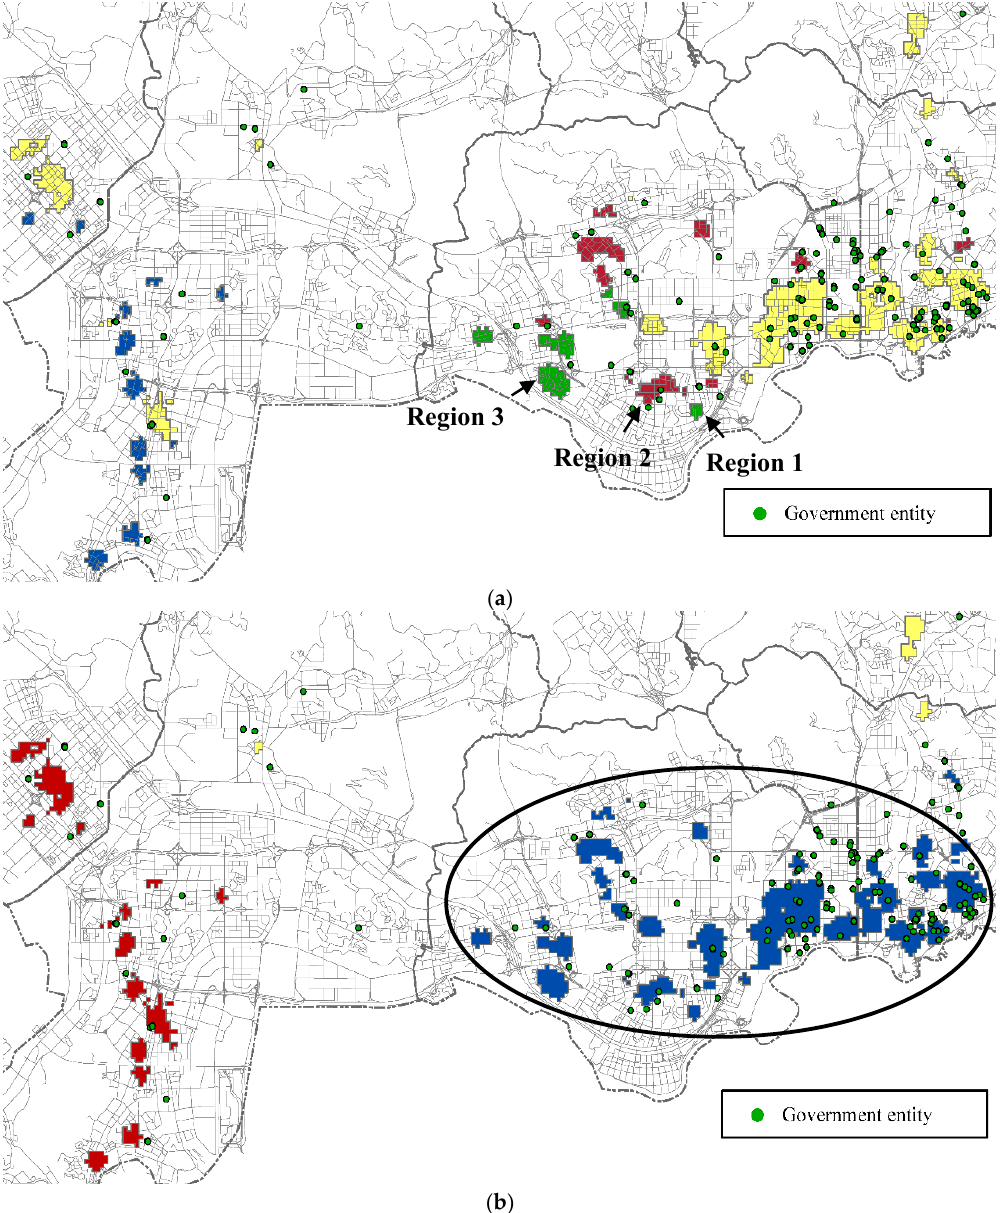
Figure 10. A more detailed comparison of clustering result: based solely on location-based variable ( b ); and based on both location-based variable and environmental variables ( a ) (i.e., the street network accessibility and the government entity density), for the size-2 pattern {bank, retail store}.